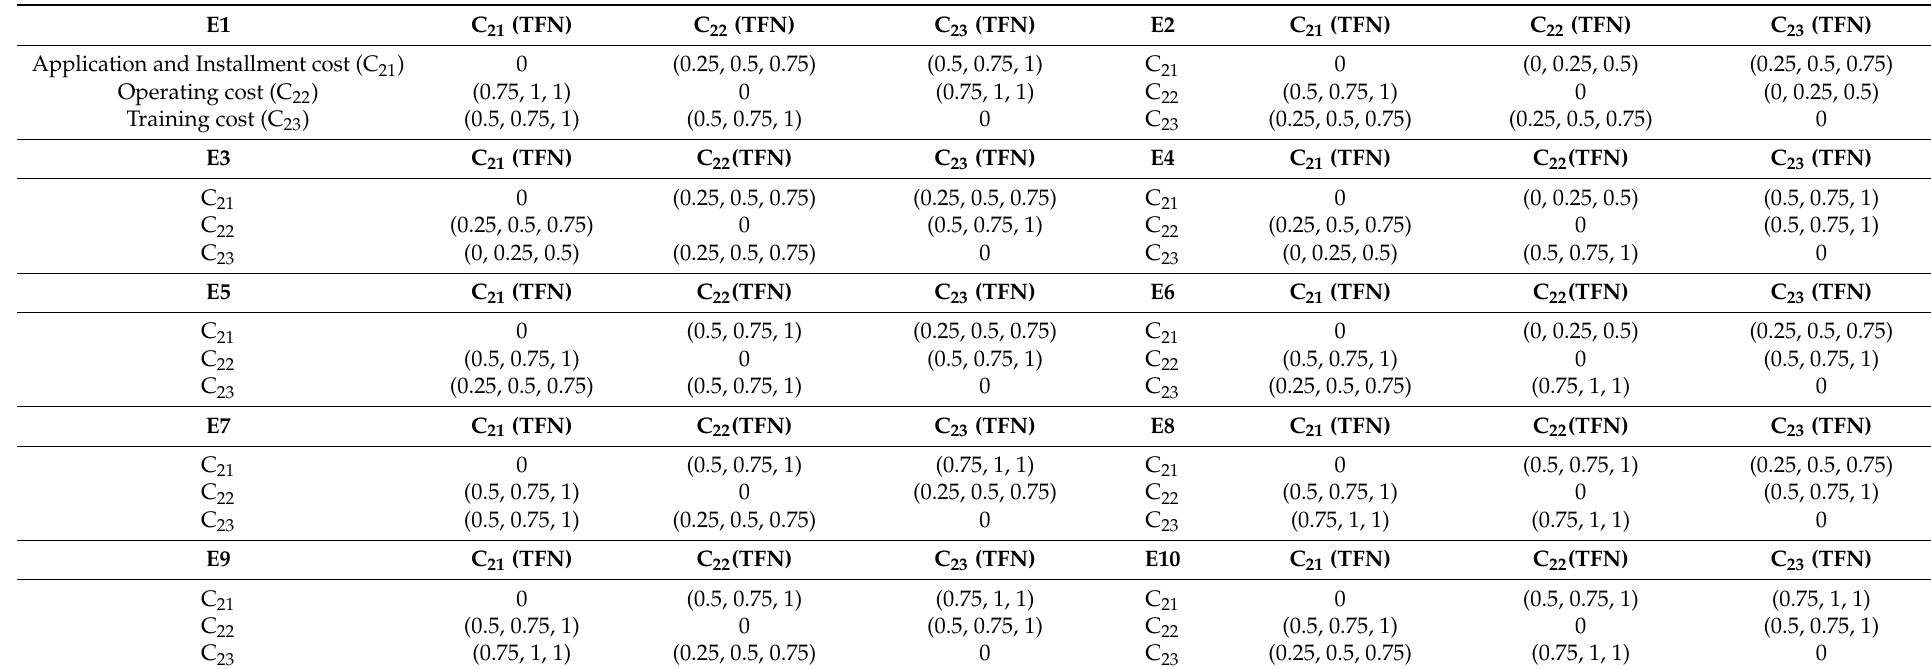
Table A8. The corresponding triangle fuzzy numbers in Table